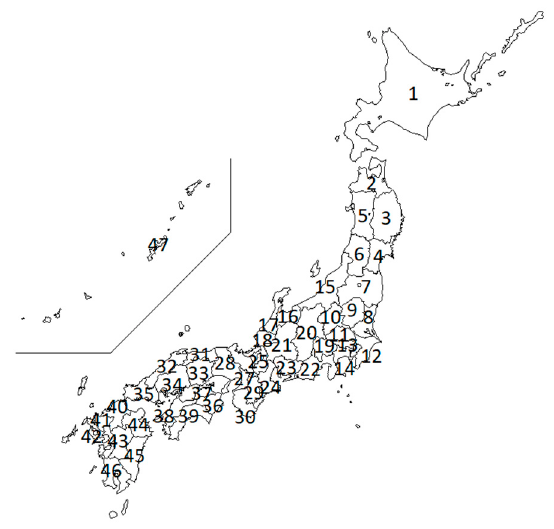
Figure 4. 47 prefectures in Japan .